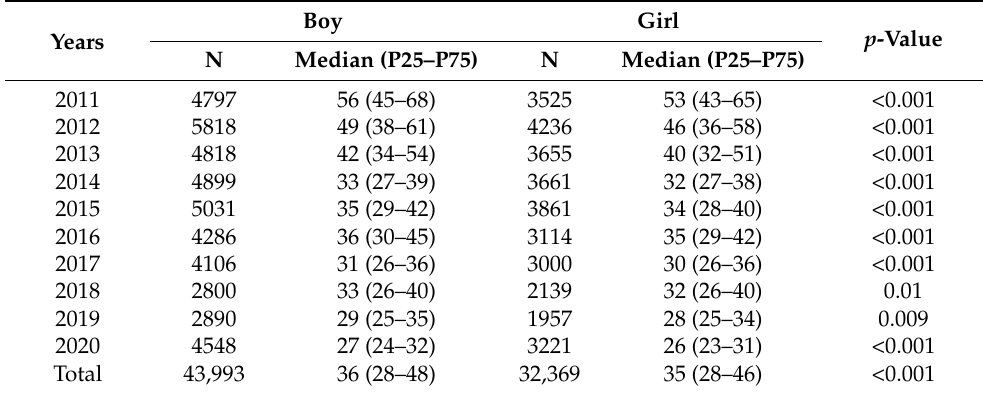
Table 1. Comparison of BLLs between boys and girls from 2011 to